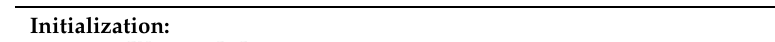
Table 3. The proposed matching